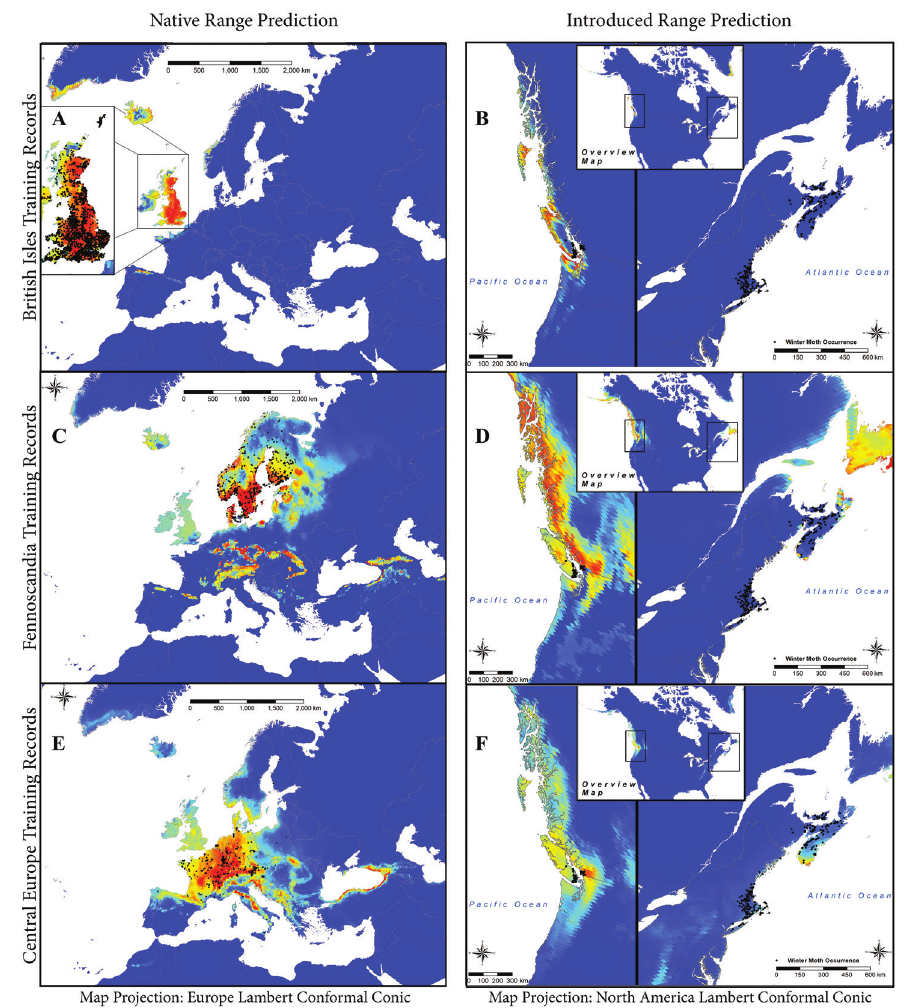
Figure 2. Model predictions for each spatial bin in the winter moth native range. The column on the left shows the winter moth training records (shown as black dots) used to make the predictions for suit- able habitat in the native range and the column on the right shows the suitable habitat prediction for the invaded range. The prediction is shown from blue (being less suitable) to red (being most